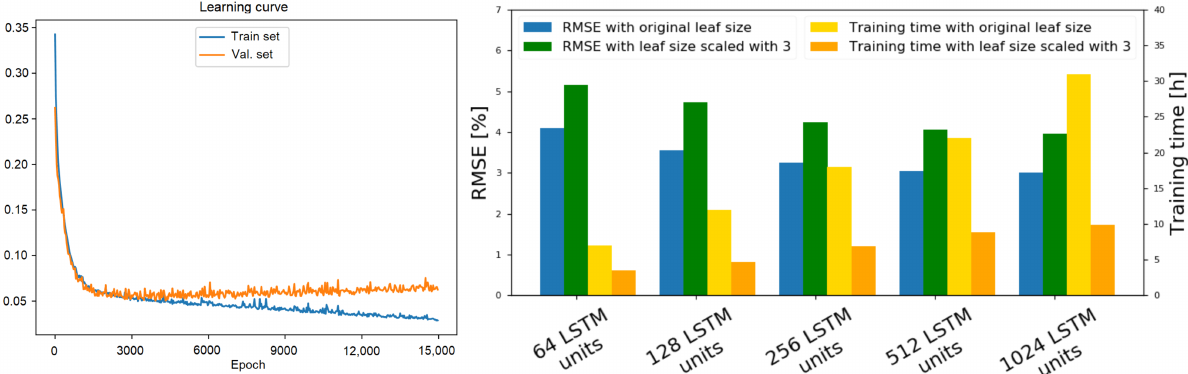
Figure 8. Learning curve and ablation of octree resolution and encoder-decoder model parameters. (left side) The evolution of the NLL loss on the training and validation set. (right side) Performance when training with different numbers of LSTM layers inside both the encoder and the decoder. We see that the RMSE percentages between the estimated and the ground truth driven trajectory decreases with respect to the added number of layers but gets capped after a certain threshold. Decreasing the resolution causes a small increase in RMSE but decreases the necessary training time in a significant